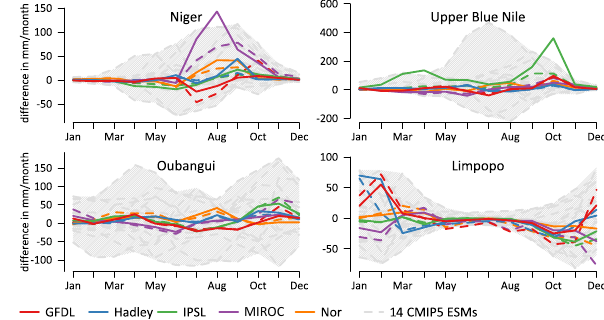
Fig. 5. Difference in monthly mean temperature in the far projec- tion period (2070–2099) relative to the base period (1970–1999) for RCP 8.5 for five bias corrected model projections (coloured lines), the uncorrected ESMs (coloured dashed lines) and 14 ENSEMBLE ESMs (grey dashed lines).